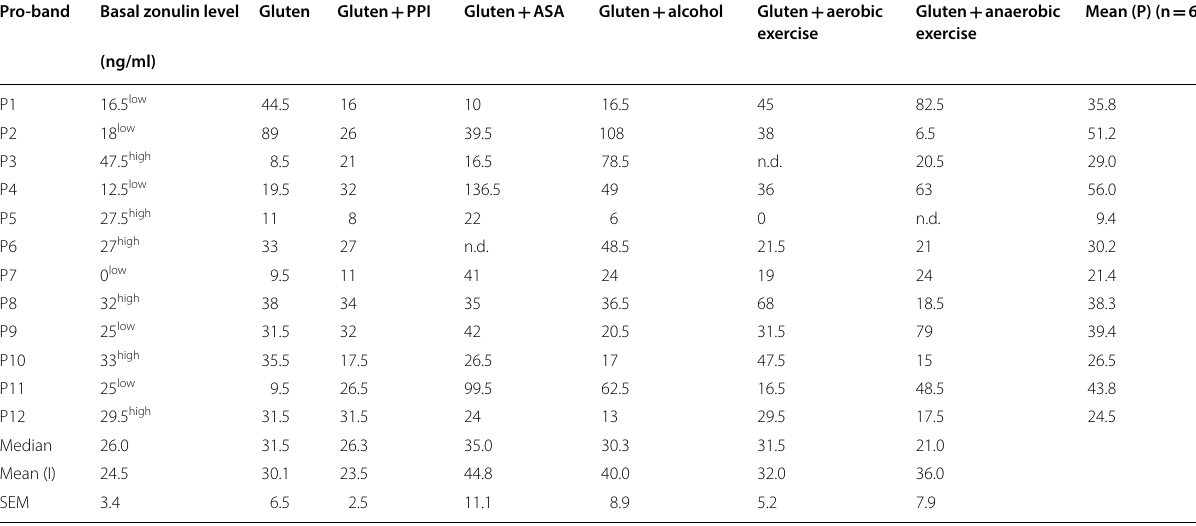
Table 4 Zonulin levels in stool at baseline (ng/ml) and after each intervention